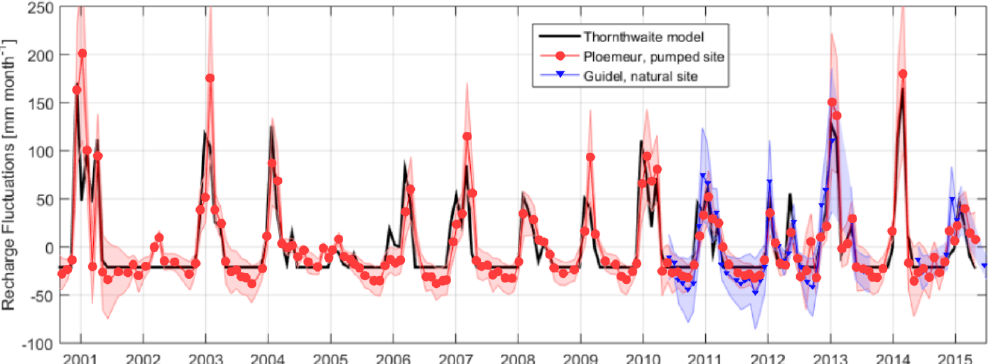
Figure 8. Monthly recharge fluctuations estimated from the groundwater analytical model at different boreholes at the Ploemeur (in red) and Guidel (blue) sites, propagating model parameter uncertainties. Shaded areas represent GW model uncertainty and variability between the different observation wells. Black line represents potential recharge fluctuations (anomalies compared to the mean value) from the Thornthwaite model.